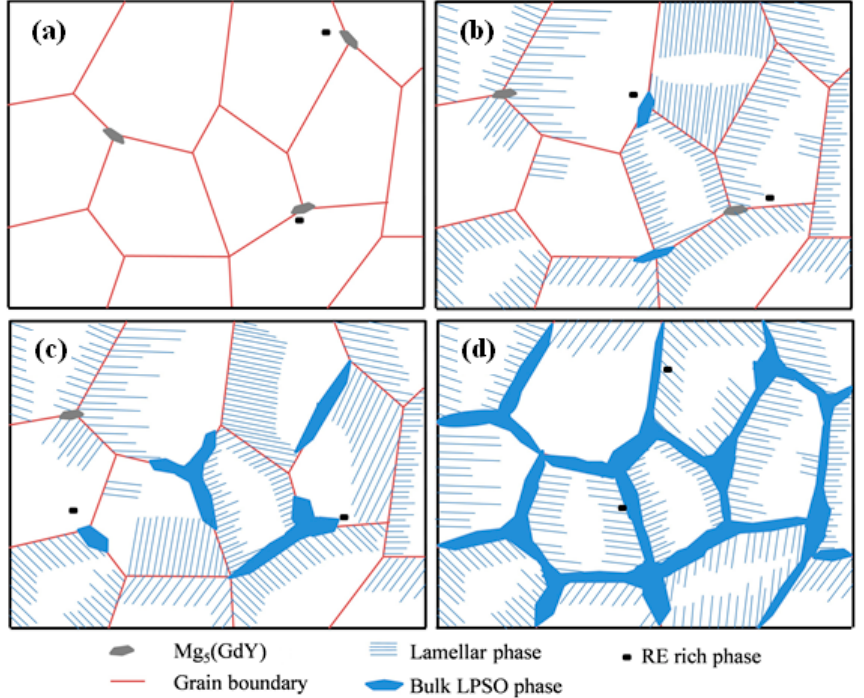
Figure 8. Effect of the Zn contents on the microstructures of the alloys: ( a ) 0Zn, ( b ) 0.7Zn, ( c ) 1.5Zn, and ( d ) 3.3Zn alloys.